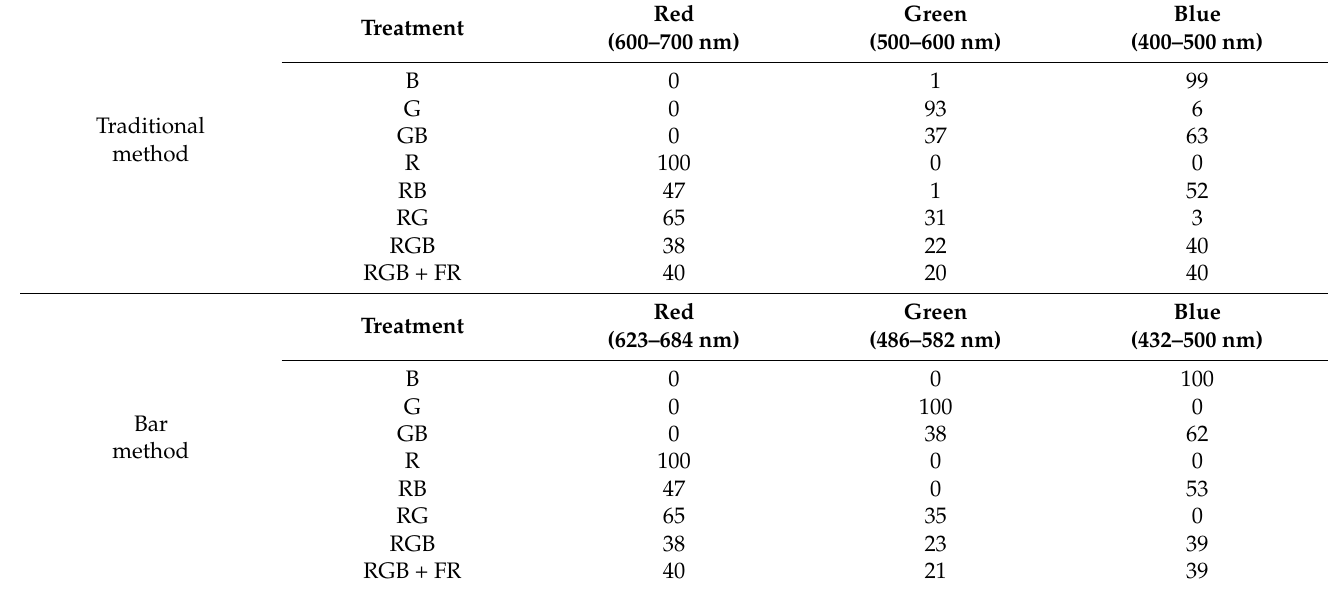
Table 4. Color breakdown for light treatment spectra as a percentage of total photosynthetic photon flux density (PPFD). Wavelength ranges for the traditional method indicate the typically defined range for each color, while the wavelength range for the bar method indicates the range in which >99% of the light is emitted from a given bar color.